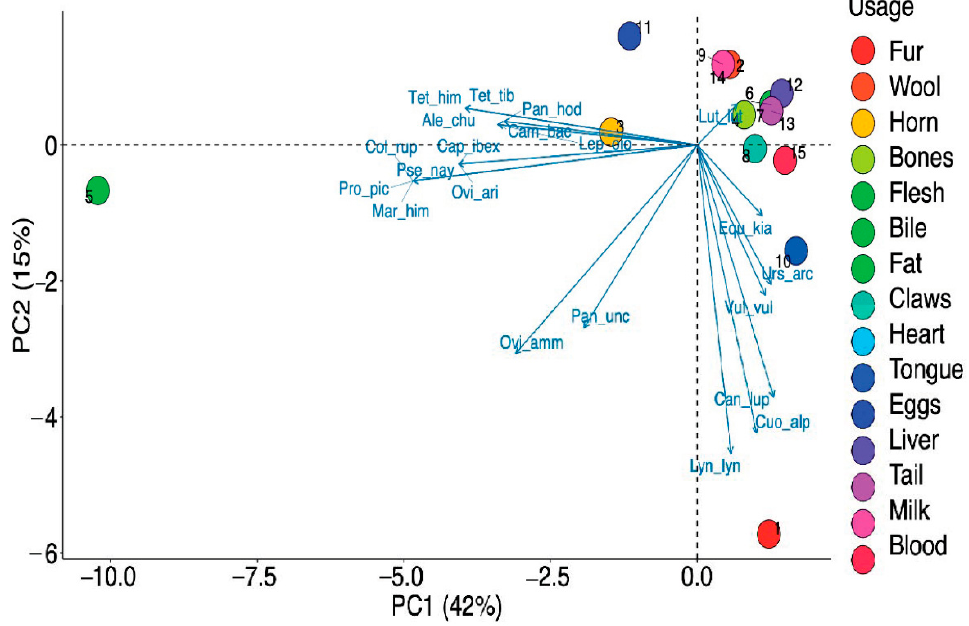
Figure 10. Principal Component Analyses (PCA) biplot of different part(s) usage.